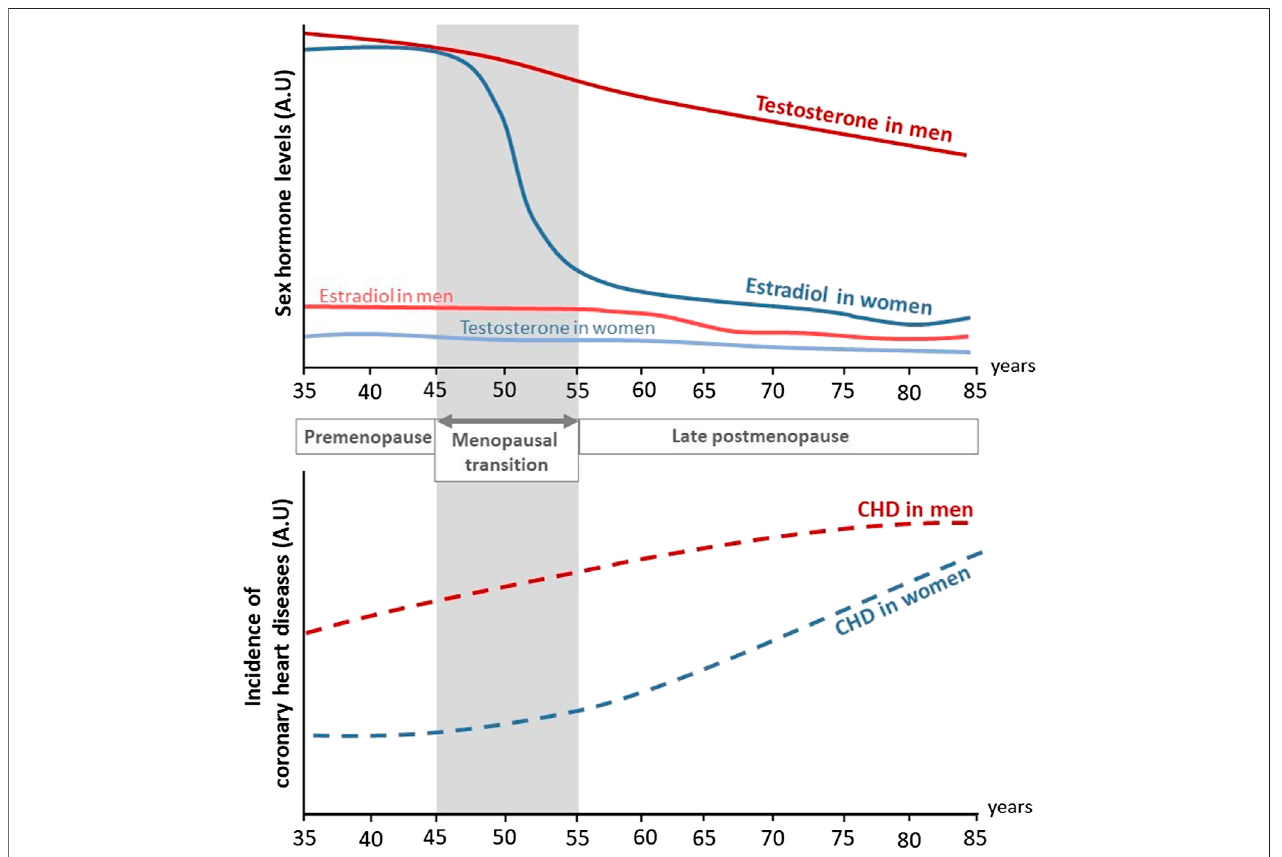
FIGURE 1 | Evolution of sex hormones levels and incidence of coronary heart diseases in men and women through life. During their life, women are at lower risk to develop coronary heart diseases (CHD) compared to men. In both sexes, aging is associated to an increased incidence of CHD. In addition, while testosterone levels decrease progressivelywithagingin men, estradiol levels rapidly dropat theonsetofmenopauseinwomenand isassociated toarise inCHD(adaptedfrom Lernerand Kannel (1986)). A.U, Arbitrary unit.